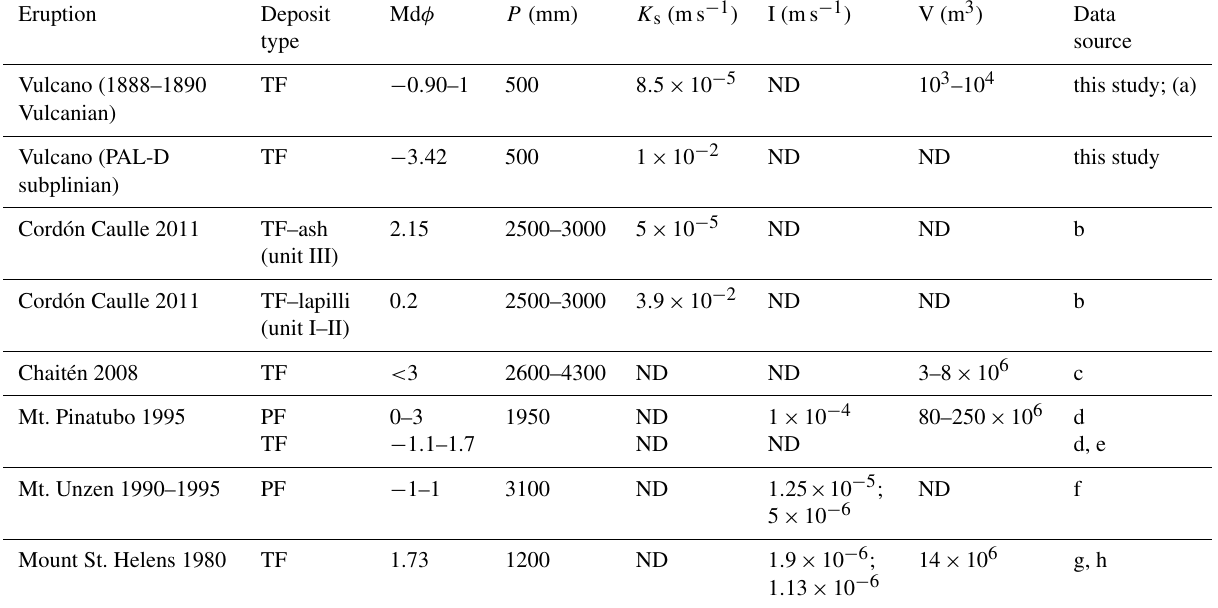
Table 7. Median grain size, hydraulic conductivity, and infiltration capacity on tephra fallout (TF) and PDC deposits measured near volcanic vents and the lahar volumes of selected examples.